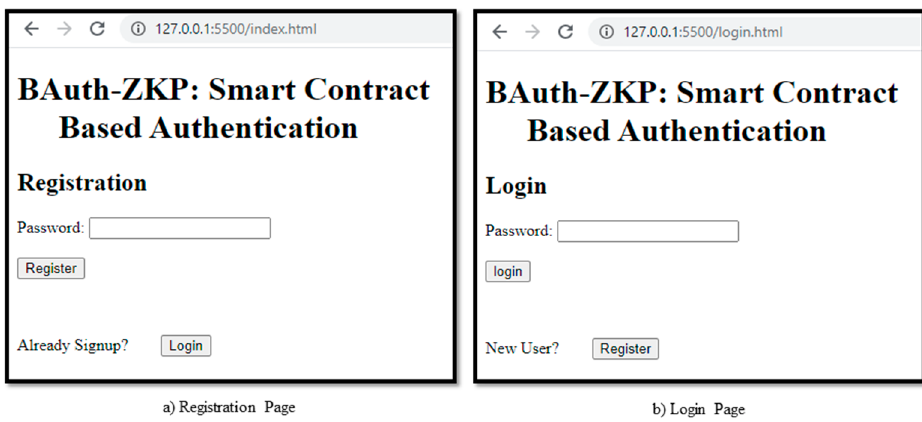
Figure 12. Proof of concept registration and login webpages of BAuth-ZKP.